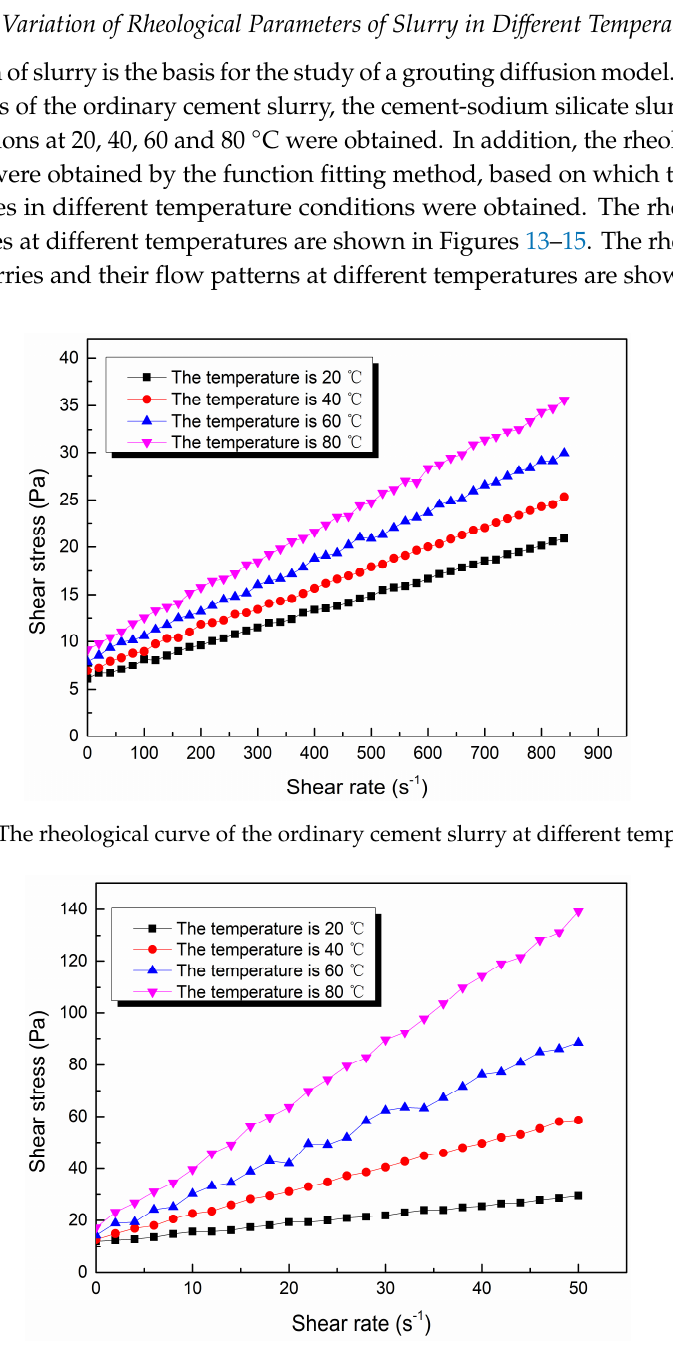
Figure 15. The rheological curve of the HGTGS at different temperatures. Table 7. The rheological equations of three kinds of slurries and their flow patterns at different temperatures. Type of Slurry